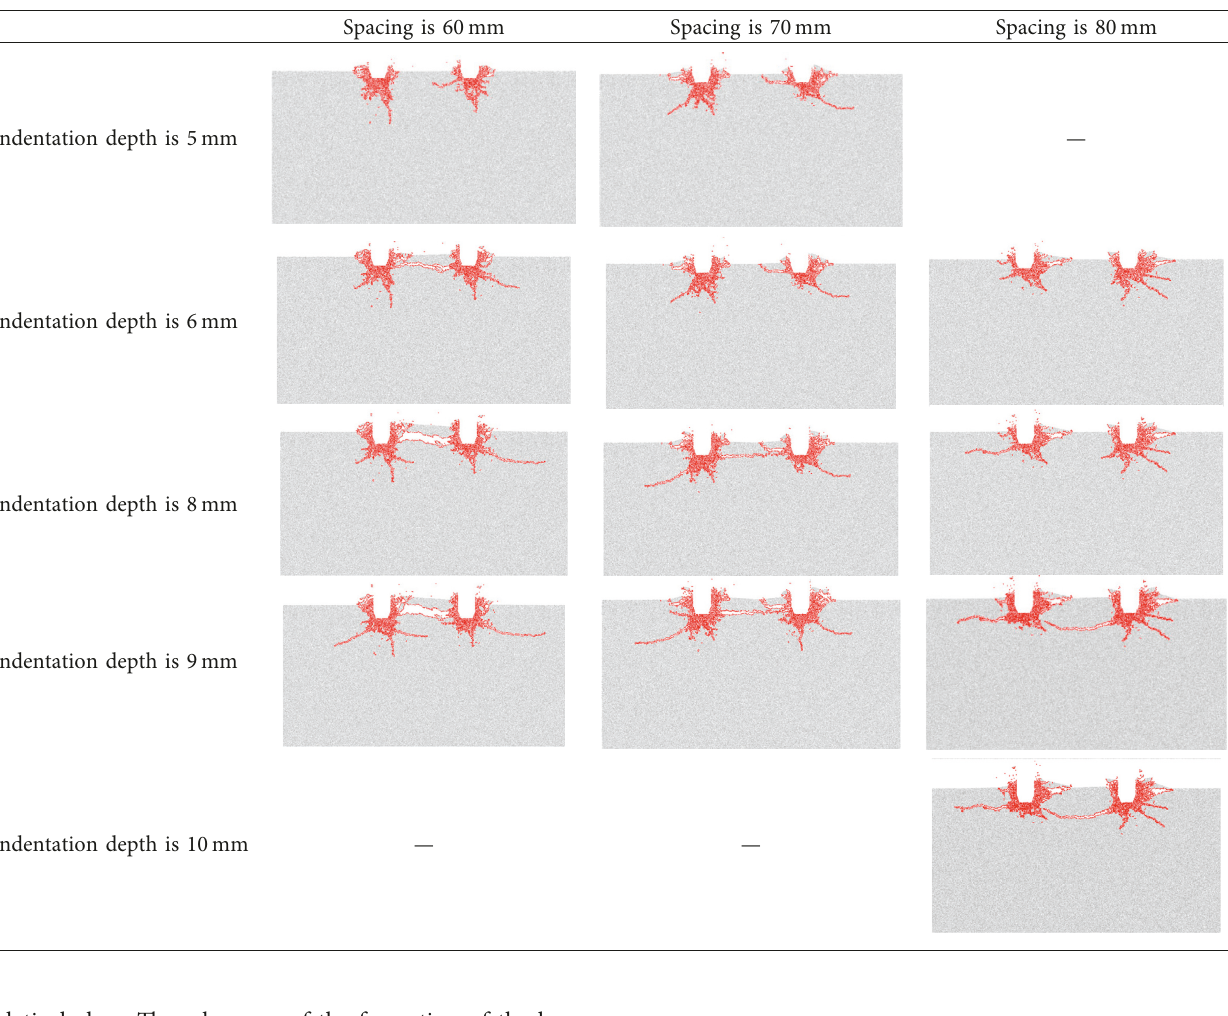
Table 4: Rock breakages for various spacings and indentation